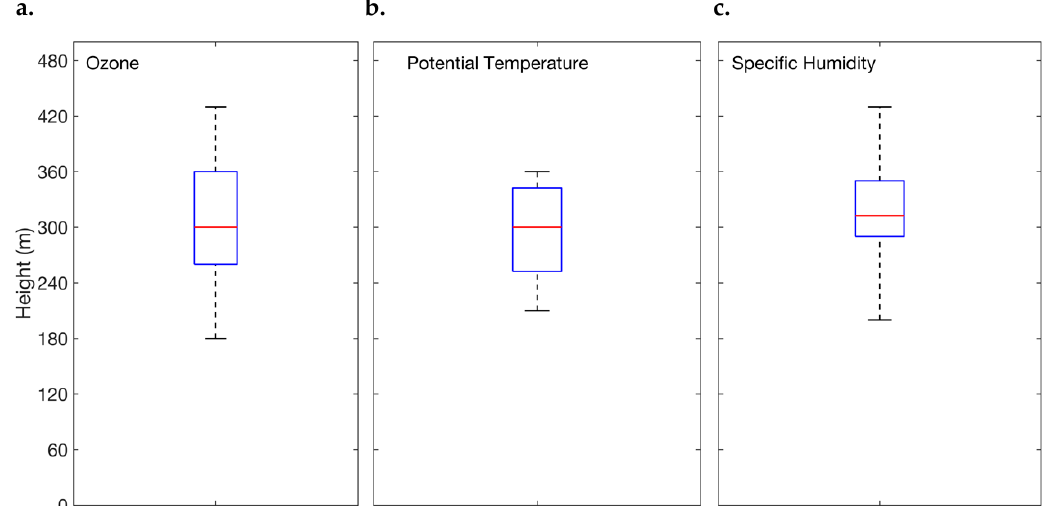
Figure 3. Box-whisker statistics plots of the height of the nighttime boundary layer during the dry season of 2018 based on ( a ) ozone concentration, ( b ) potential temperature, and ( c ) specific humidity (84 flights). The median (red line), quartiles (blue box edges), and the minimum and maximum values (black lines) are represented, excluding outliers. Flights took place between 20:00 and 00:00 (LT). Local time (LT) was 4 h earlier than UTC.